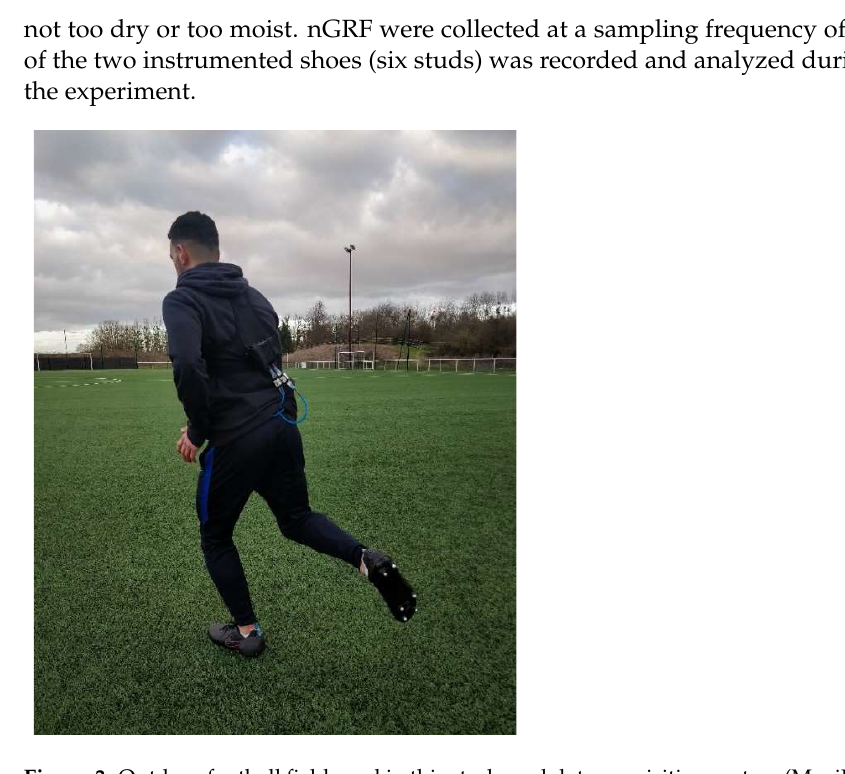
Figure 3. Outdoor football field used in this study and data acquisition system (MaxiPhyling, Phyling, France) connected to each shoe by a wire and worn by subjects in a lightweight sport vest.